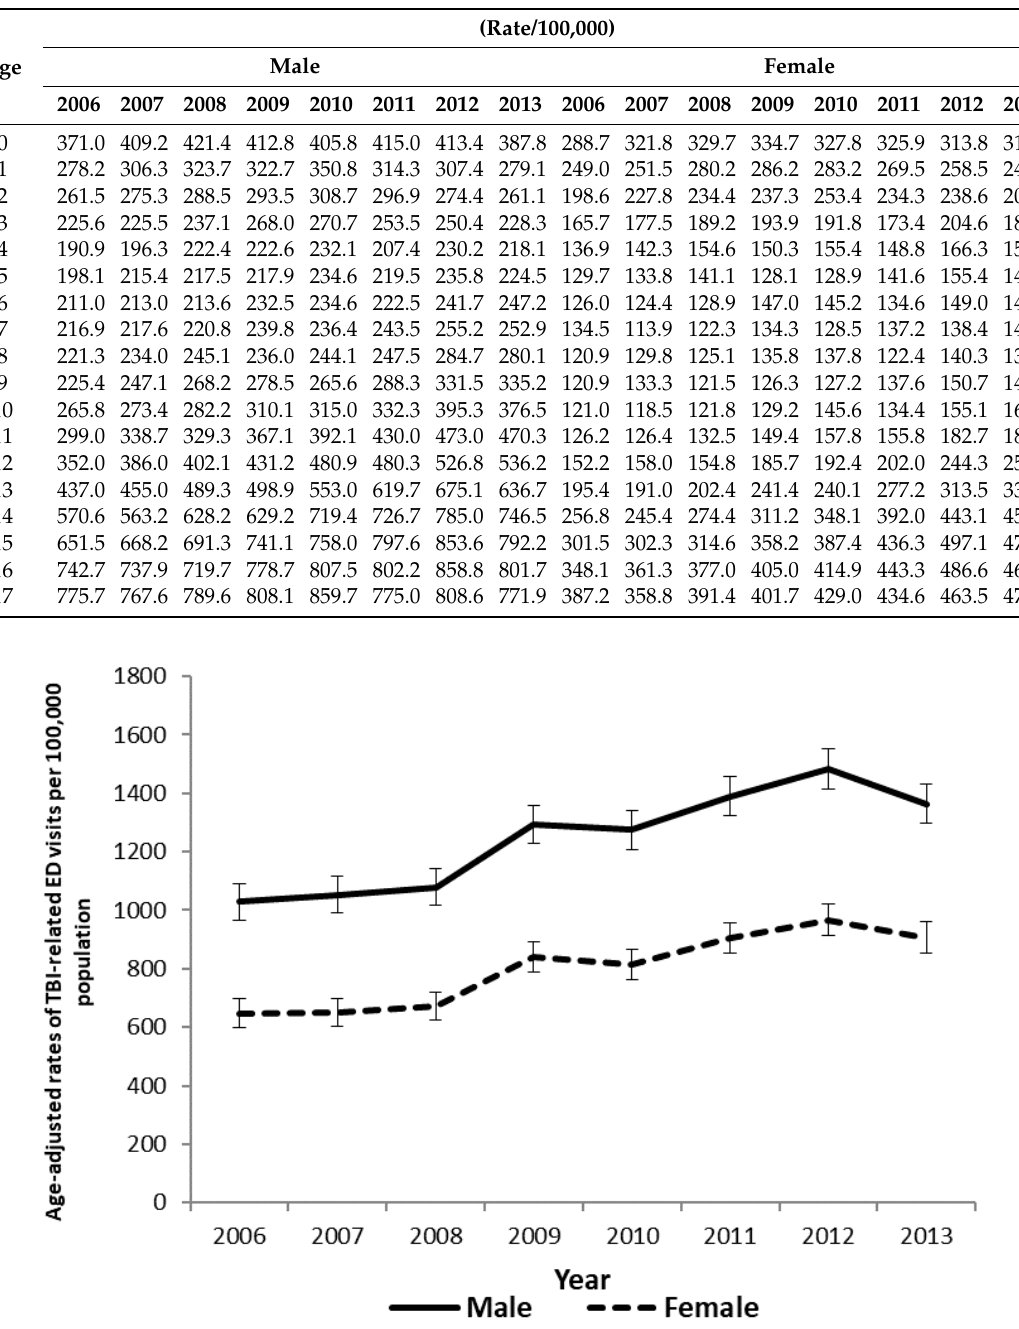
Table 1. Crude rates of trauma brain injury (TBI)-related emergency department (ED) visits by age and sex in the U.S., 2006–2013.